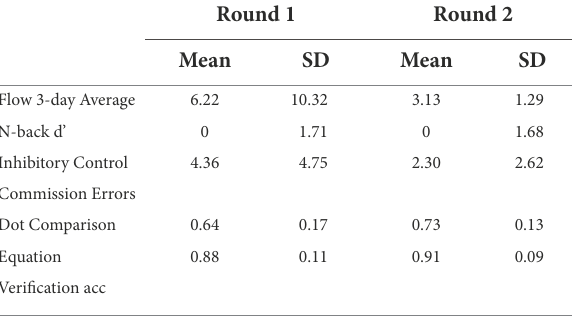
TABLE 2 Descriptive statistics in Round 1 ( n = 28) and Round 2 ( n = 23).